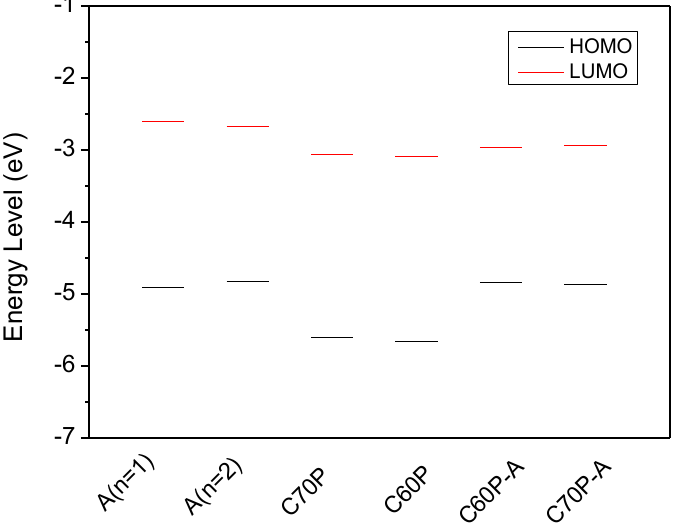
Figure 2. Energy levels of polymers and fullerene, where (APFO 3 ) n =1 , (APFO 3 ) n =2 , [C70]PCBM, [C60]PCBM, [C60]PCBM/(APFO 3 ) n =1 and [C70]PCBM/(APFO 3 ) n =1 are abbreviated as A( n = 1), A( n = 2), C70P, C60P, C60P-A and C70P-A,